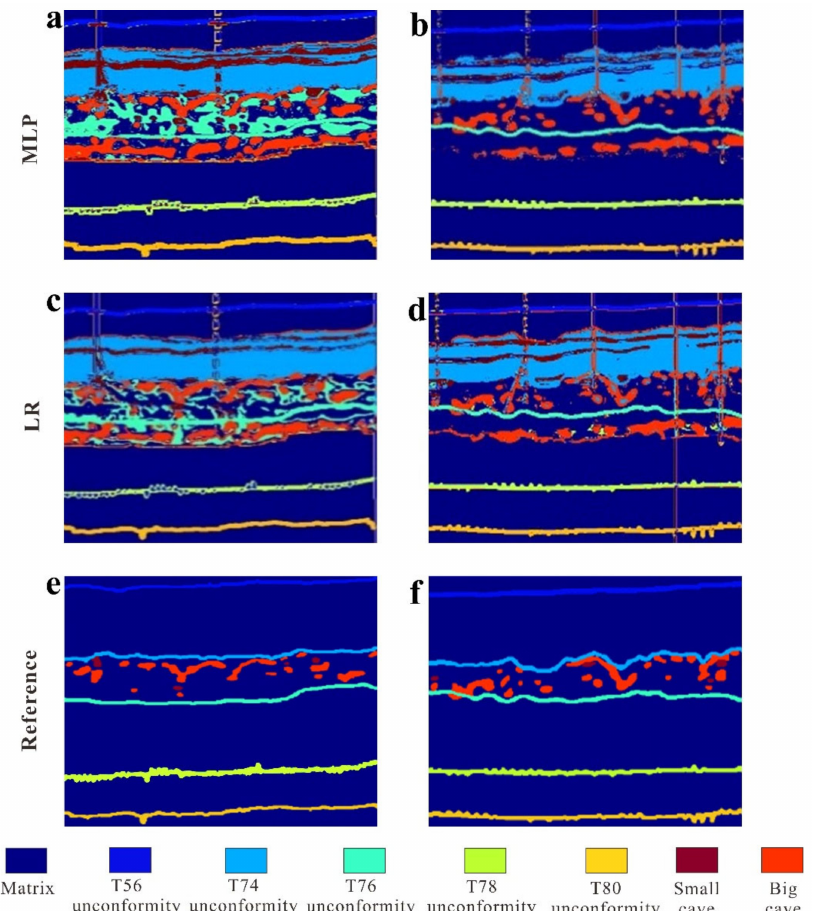
Figure 18. Comparison of images predicted by MLP ( a , b ), LR ( c , d ), and reference images ( e , f ).